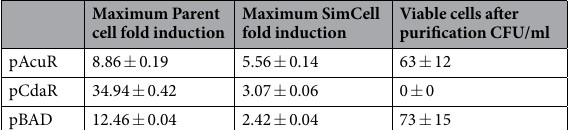
Table 1. Summary of induction ratios in parent cells and purified SimCells and plate counts of